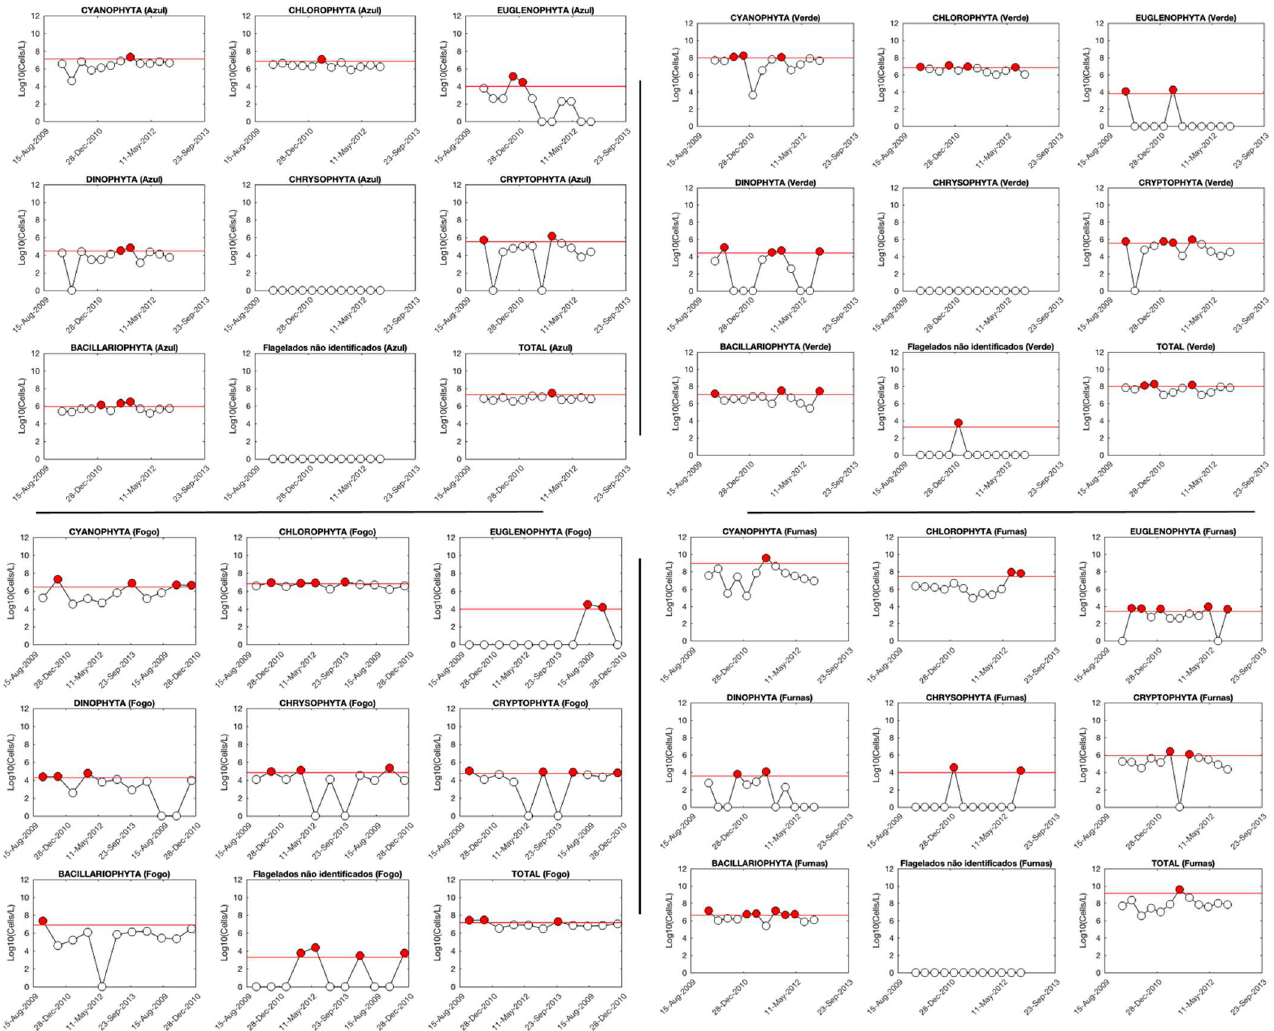
Figure 10. The abundance of phytoplankton in the period 2010 to 2012 for Blue, Green, Fogo, and Furnas Lake with the indication of threshold levels to perform the ANOVA